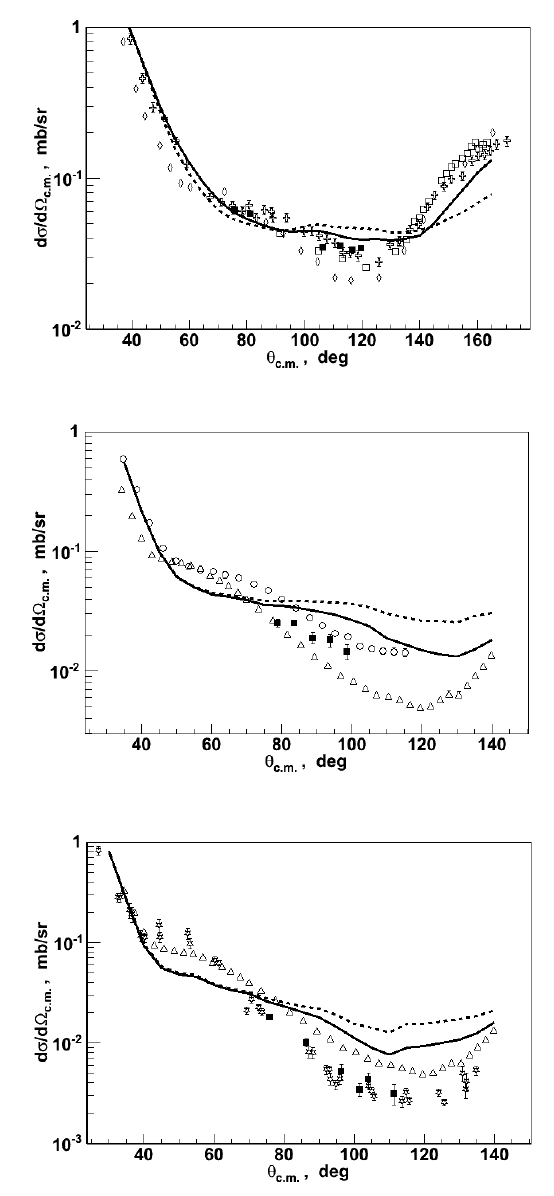
Figure 4. Di ff erential cross section